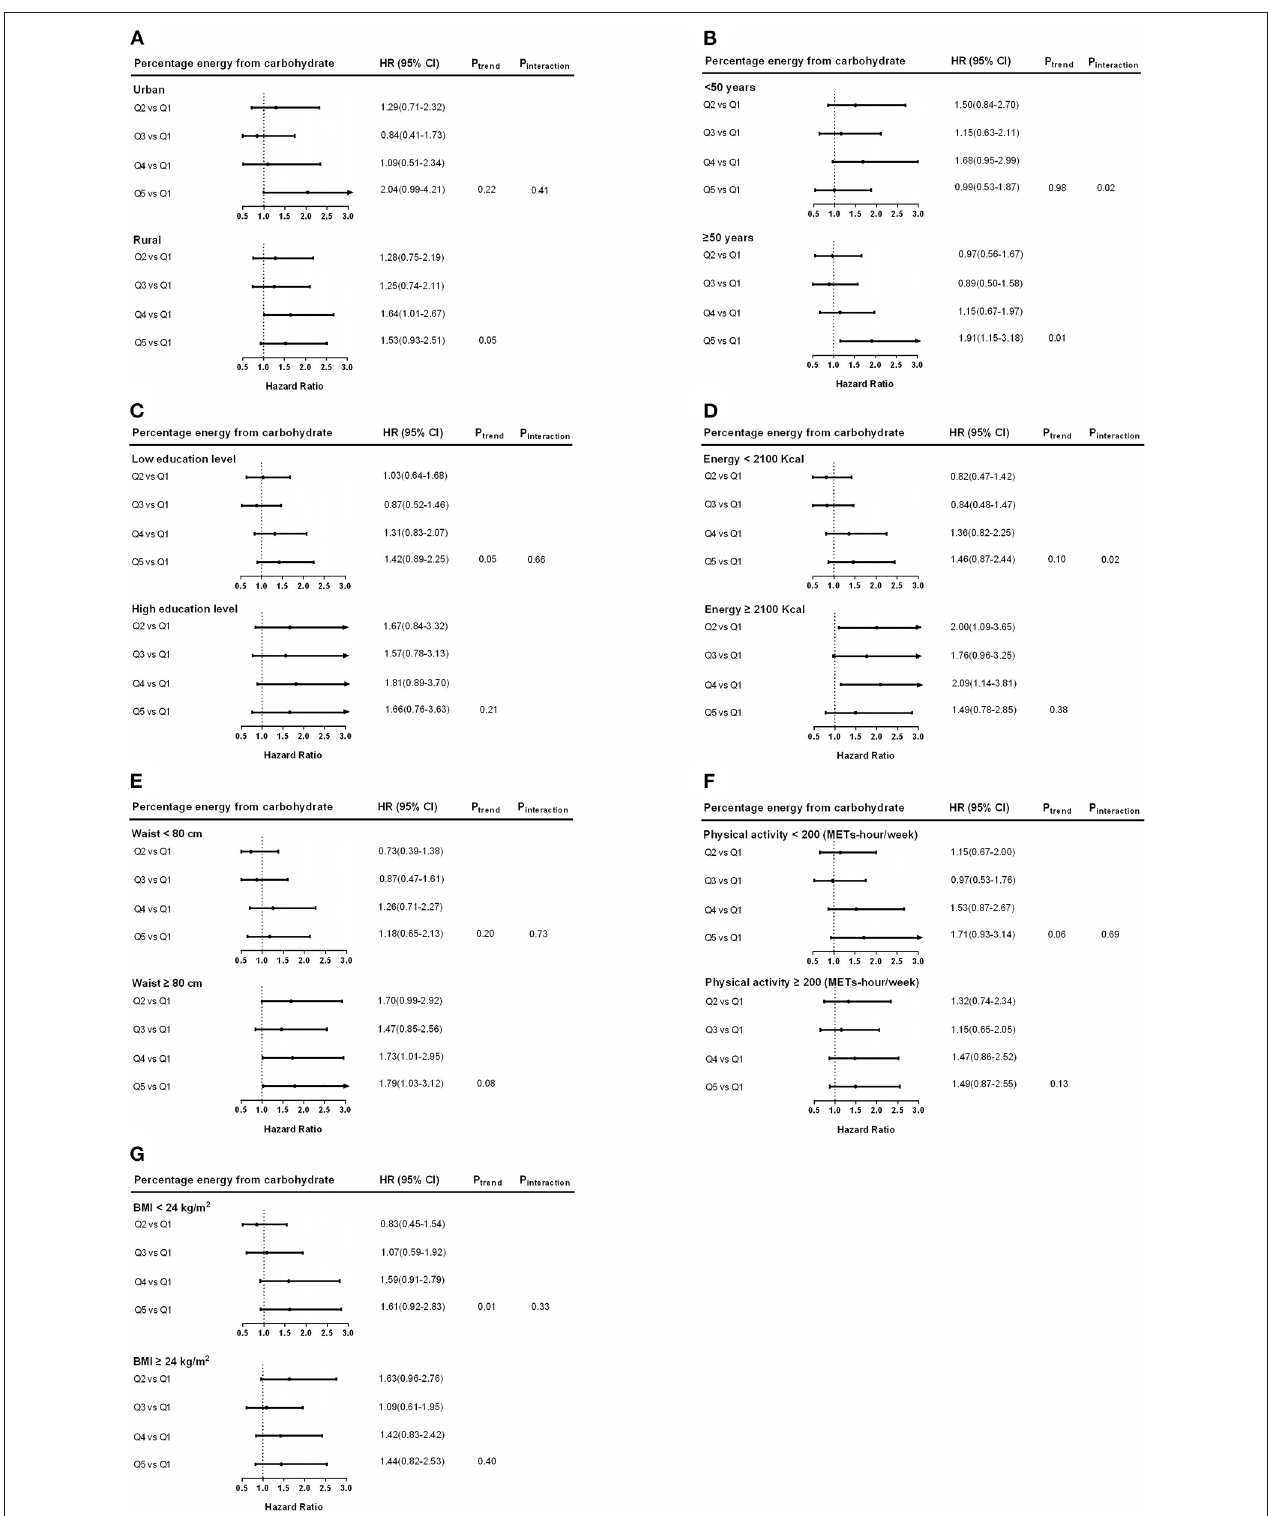
FIGURE 5 | Hazard ratios (HRs) for SDH risk for percentage energy from carbohydrate in subgroups among women. Hazard ratios and 95% CIs are adjusted for age, urban or rural location, education, waist circumference, ever smoking (never, ever), alcohol drinking (abstainer or drinker), personal income, BMI (underweight, normal weight, overweight, and obesity), physical activity, and energy intake. Hazard ratios (95% CIs) of hypertension among women by region (A) , age (B) , education levels (C) , energy intake (D) , waist circumference (E) , physical activity (F) , and BMI (G) are shown. Ptrend, P for trend; Pinteraction, P for interaction.